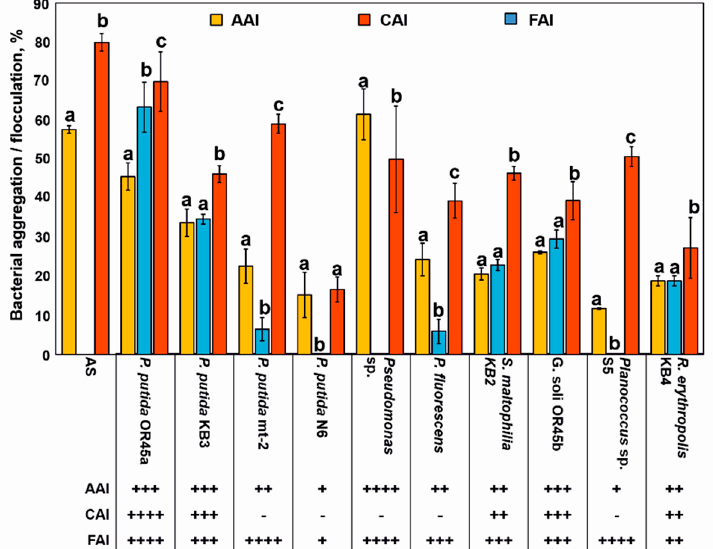
Figure 3. Analysis of the ability of the tested strains to incorporate into the AS floc structure. AAI— auto-aggregation index, CAI—co-aggregation index, FAI—bio-flocculation index, (++++) strong ability, (+++) good ability, (++) weak ability, (+) very weak ability, ( − ) lack of ability.